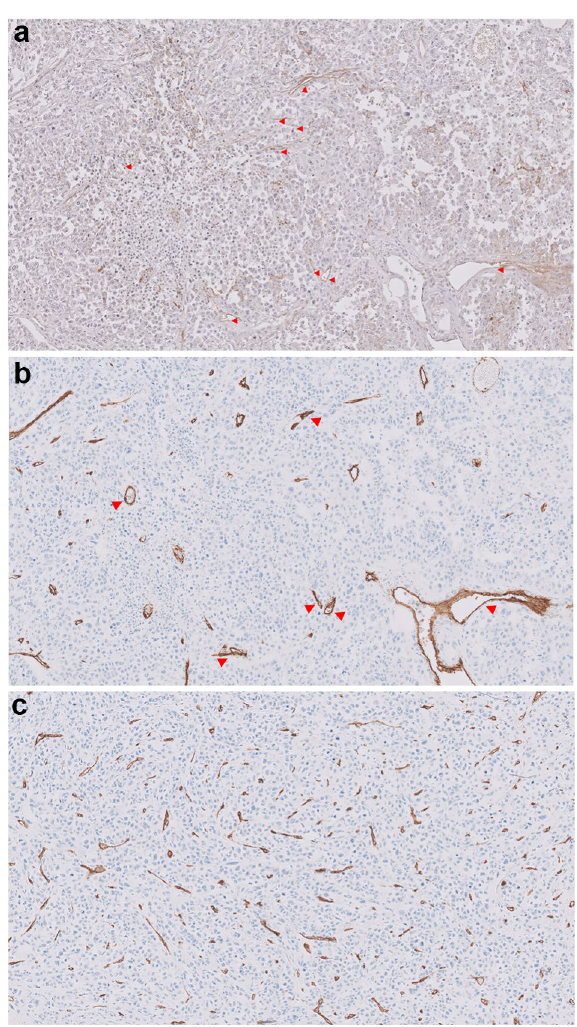
Figure 2. Low positive CD34 MVD in recurrent breast cancer. Immunohistochemical staining of Notch1 ( a ) and CD34 ( b ) at Notch 1 hotspots (original magnification ×200). Red arrow heads indicate Notch 1 positive microvessels ( a ), and some of CD34 positive microvessels are noted ( b ) among Notch 1 positive microvessels. In the same patient, ( c ) shows high level of CD34 MVD (brown colored) measurement in the entire tissue. However, the positivity of CD34 MVD in Notch 1 hotspots was as low as shown in ( b ). The patient was diagnosed as recurrent breast cancer 3 months after